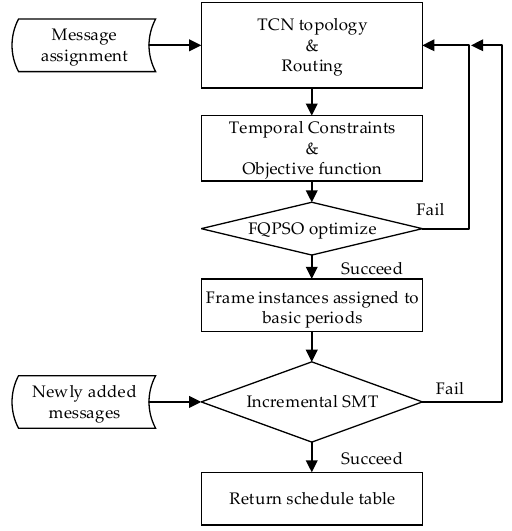
Figure 5. Ethernet train communication network topology.